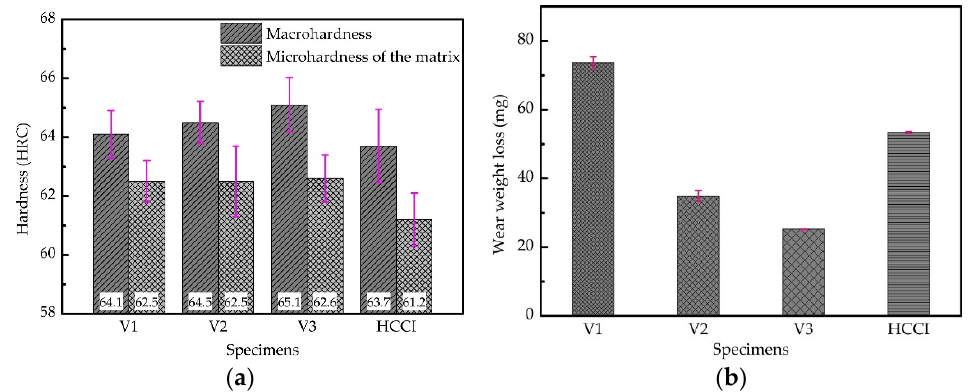
Figure 5. Comparison of macrohardness, microhardness of the matrix, and wear resistance between low-vanadium wear-resistant alloys and HCCI: ( a ) macrohardness and microhardness of the matrix comparison, ( b ) wear resistance comparison.